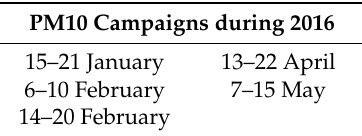
Table 1. List of one-week measurement campaigns.